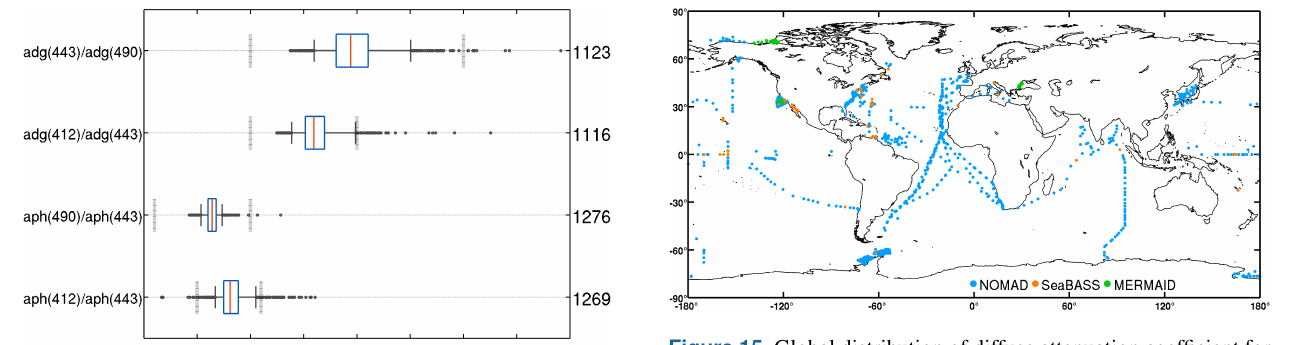
Figure 15. Global distribution of diffuse attenuation coefficient for downward irradiance (kd) per dataset in the final